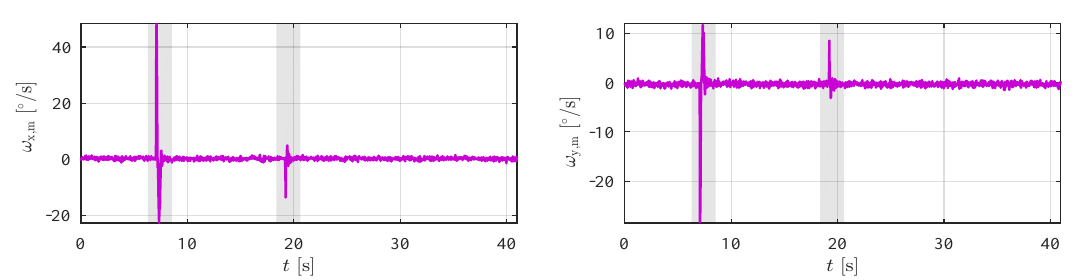
Figure 7. Angular rate ω y and ω z , respectively, measured by the gyros for the third experiment, scenario (ii).